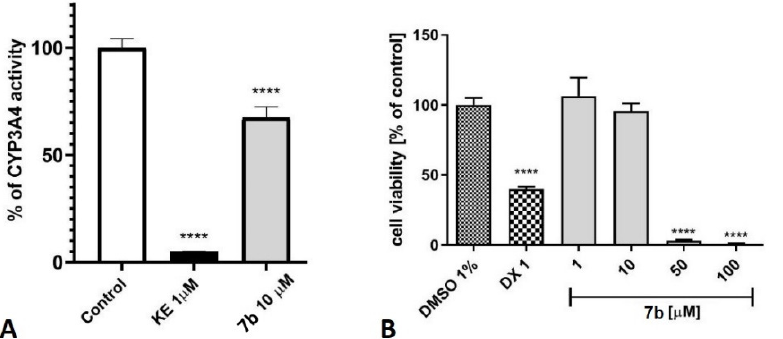
Figure 3. ( A ): The cytostatic activity (after 72 h) of 7b · HCl and reference doxorubicin (DX) on hepa- toma HepG2 (37 °C, 5% CO 2 ). ( B ): The inhibition of CYP3A4 by 7b·HCl and reference ketoconazole ( KE ). One-way ANOVA and Bonferroni’s Comparison Test were used to determine statistical sig- nificance (**** p < 0.0001 compared with negative control)